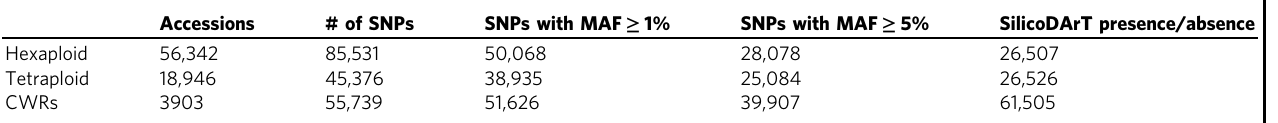
Table 1 Number of segregating SNPs and distribution of minor allele frequencies (MAF) across data sets after fi ltering for missing rate > 50% and MAF ≤